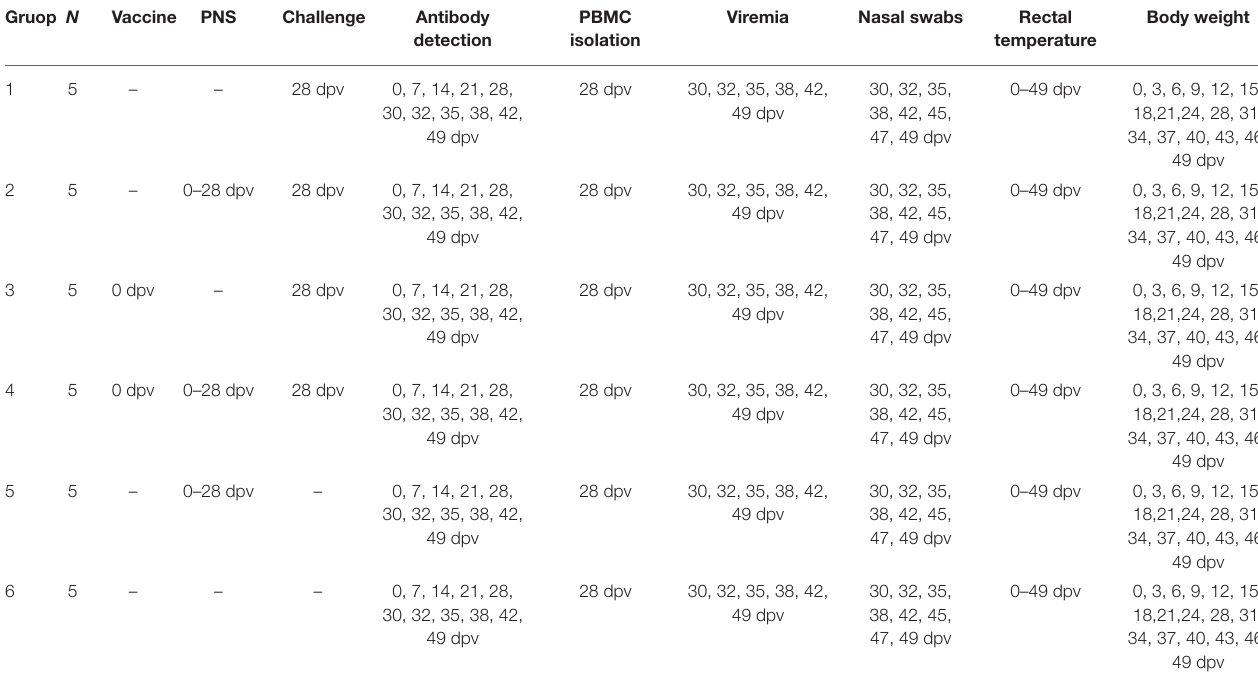
TABLE 2 | Summary of experiment schedule. Gruop